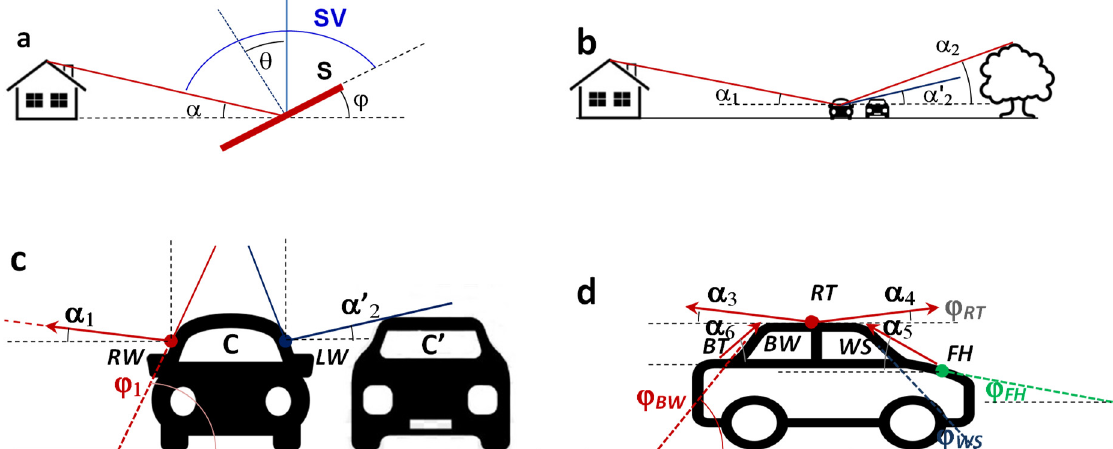
Figure 1. ( a ) Definition of the apparent angle above horizontal α of nearby obstacles, angle φ of the condensing surface S with horizontal, skyview angle SV, and sky radiation angle θ with vertical. ( b – d ) Effect of obstacle radiations from ground and obstacles (angle α + φ ) and skyview limitation (angle 180° − α − φ ). Other notations: see text.